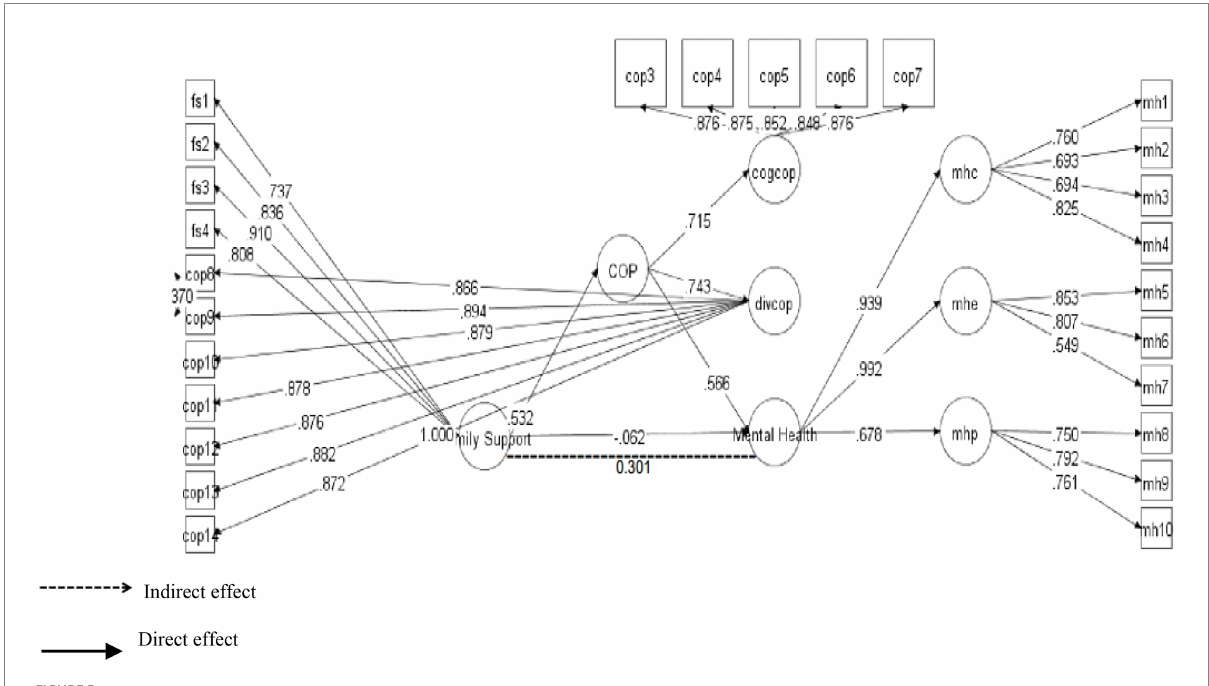
FIGURE 5 Mediation of coping strategy between FS and MH.